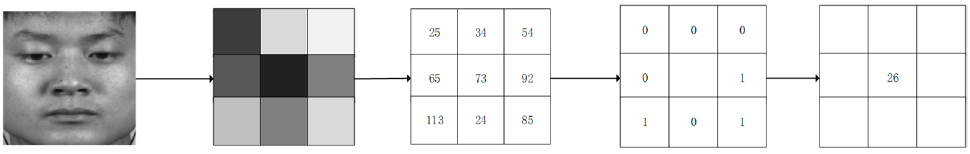
Figure 2. Example of encoding a LBP feature.